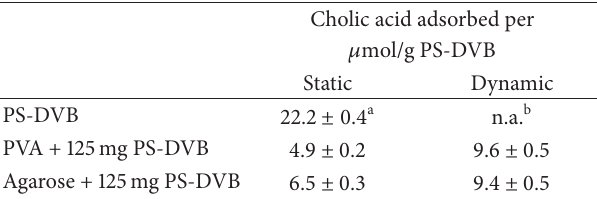
Table 3: Adsorption of cholic acid under static and dynamic conditions after 60min ( 𝑛 = 3